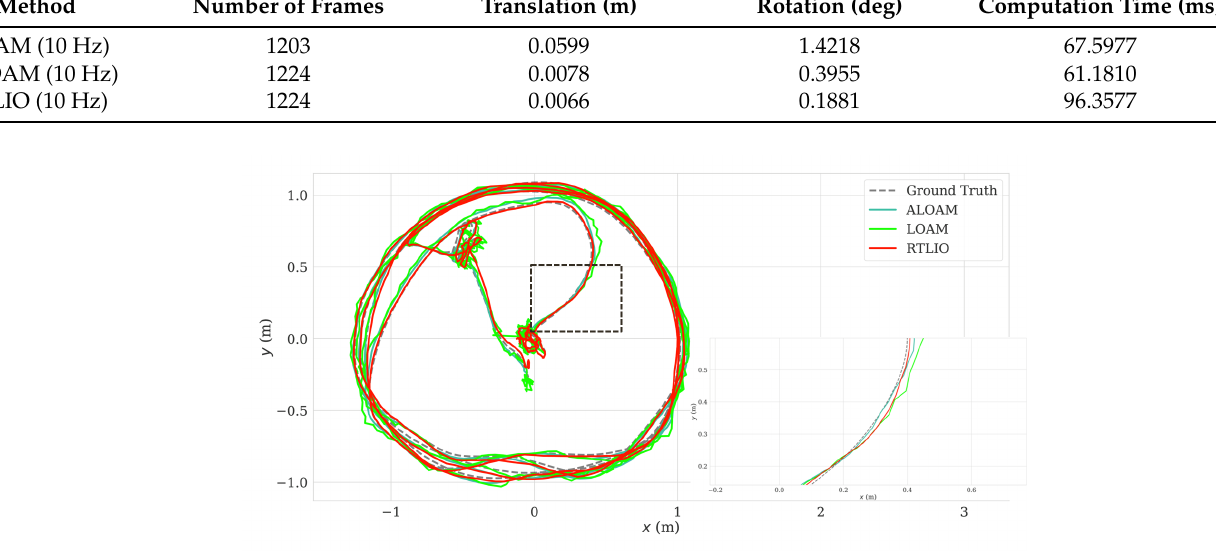
Figure 9. The comparison of trajectory with LOAM, ALOAM,